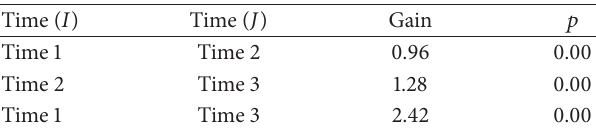
Table 10: Bonferroni pairwise comparisons for the productive